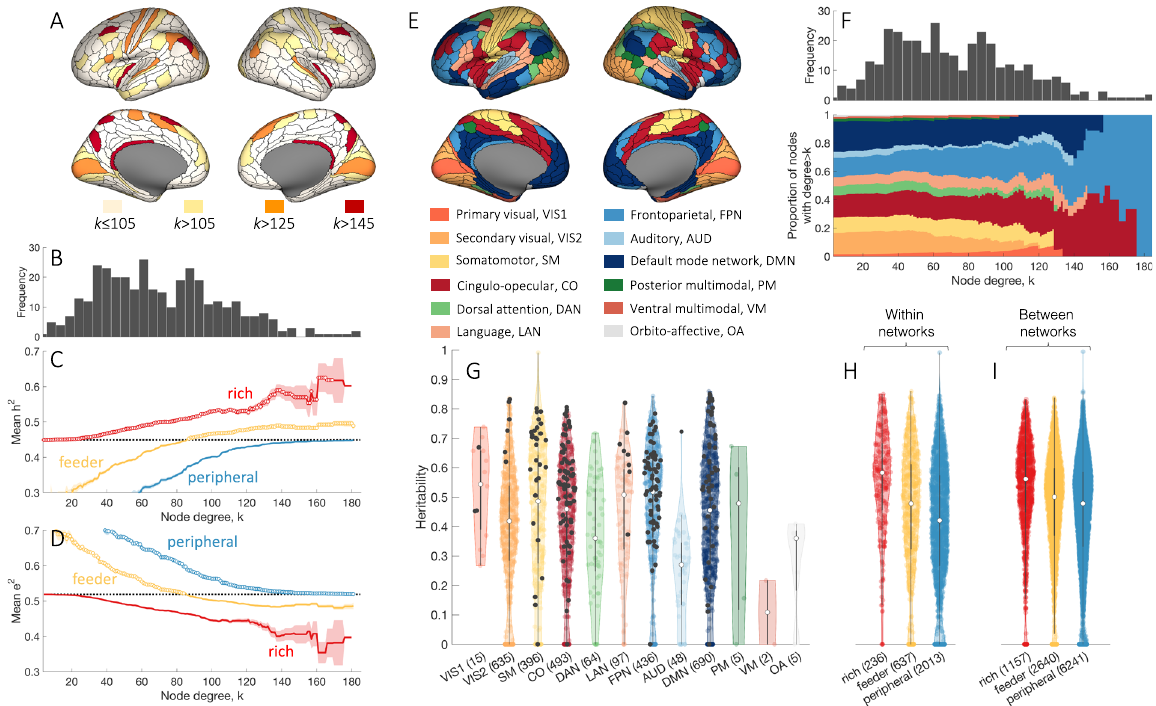
Fig. 2 Genetic in fl uences on connectivity strength are preferentially concentrated on rich-club links. A Anatomical locations of hubs de fi ned at different levels of k . B The degree distribution of the representative group-level connectome. Mean genetic ( C ) and unique environmental ( D ) in fl uences for rich (hub – hub), feeder (hub – nonhub), peripheral (nonhub – nonhub) connections as a function of the hub-de fi ning threshold, k . The mean of the corresponding measure across all network links is shown as a dotted black line. Shaded area corresponds to the standard error of the mean, circles indicate a statistically signi fi cant increase of the measure in a given link type compared to the rest of the network (one-sided Welch ’ s t -test, uncorrected p < 0.05). E Regional assignments to canonical functional network modules 38 , represented using color. F The proportion of nodes with degree > k in each functional network module as a function of k . G Distributions of heritability estimates across edges within functionally de fi ned networks 38 : VIS1 — primary visual; VIS2 — secondary visual; SM — somatomotor; CO — cingulo-opecular; DAN — dorsal attention; LAN — language; FPN — frontoparietal; AUD — auditory; DMN — default mode; PM — posterior multimodal; VM — ventral multimodal; OA — orbito-affective. Rich links within each module are represented as black dots, as de fi ned for k > 105. Heritability distributions for edges within ( H ) and between ( I ) functional modules across rich, feeder, and peripheral link types for k > 105. Rich links show signi fi cantly higher heritability compared to both feeder and peripheral links, within and between functional modules (one-sided Welch ’ s t -test, all p < 1.9 × 10 − 12 ). For distributions presented in G – I , white dots represent median values for each distribution. The interquartile range is represented with a dark gray box, whiskers are represented with a light gray line. Source data are provided as a Source Data fi